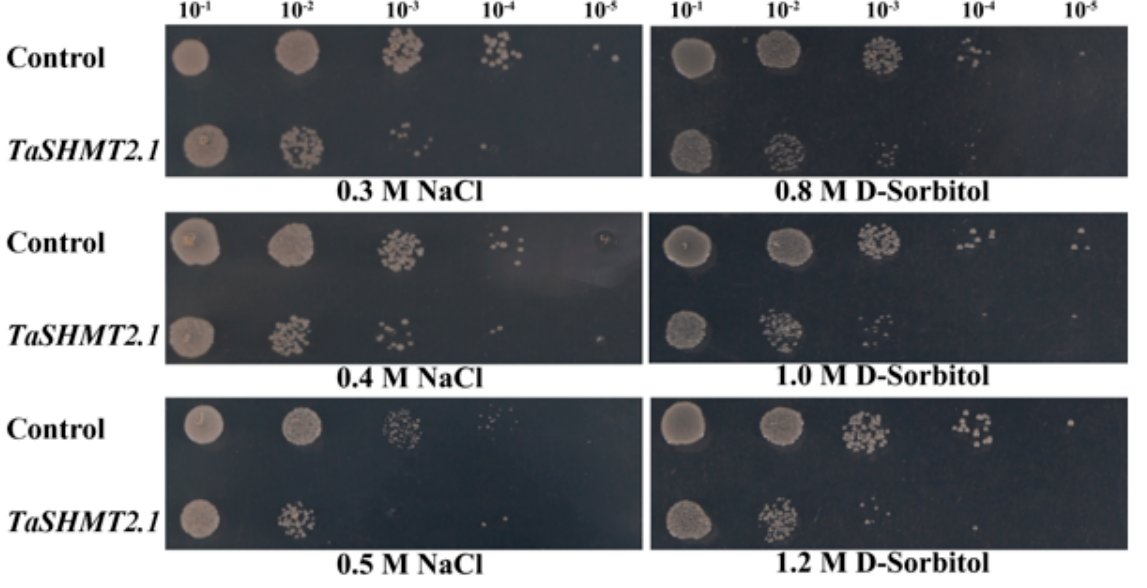
Figure 7. The ability of the tolerance in response to salt and dehydration stress in recombinant yeast cells. The yeast cells BY4741( ∆ hog1 ) carrying the empty vector (pGADT7, negative control) and pGADT7 − TaSHMT2.1 were spotted onto SD/-Leu medium plates containing NaCl (0.3, 0.4, and 0.5 M) or D − Sorbitol (0.8, 1.0, and 1.2 M), and cultured at 30 °C for 3 days.